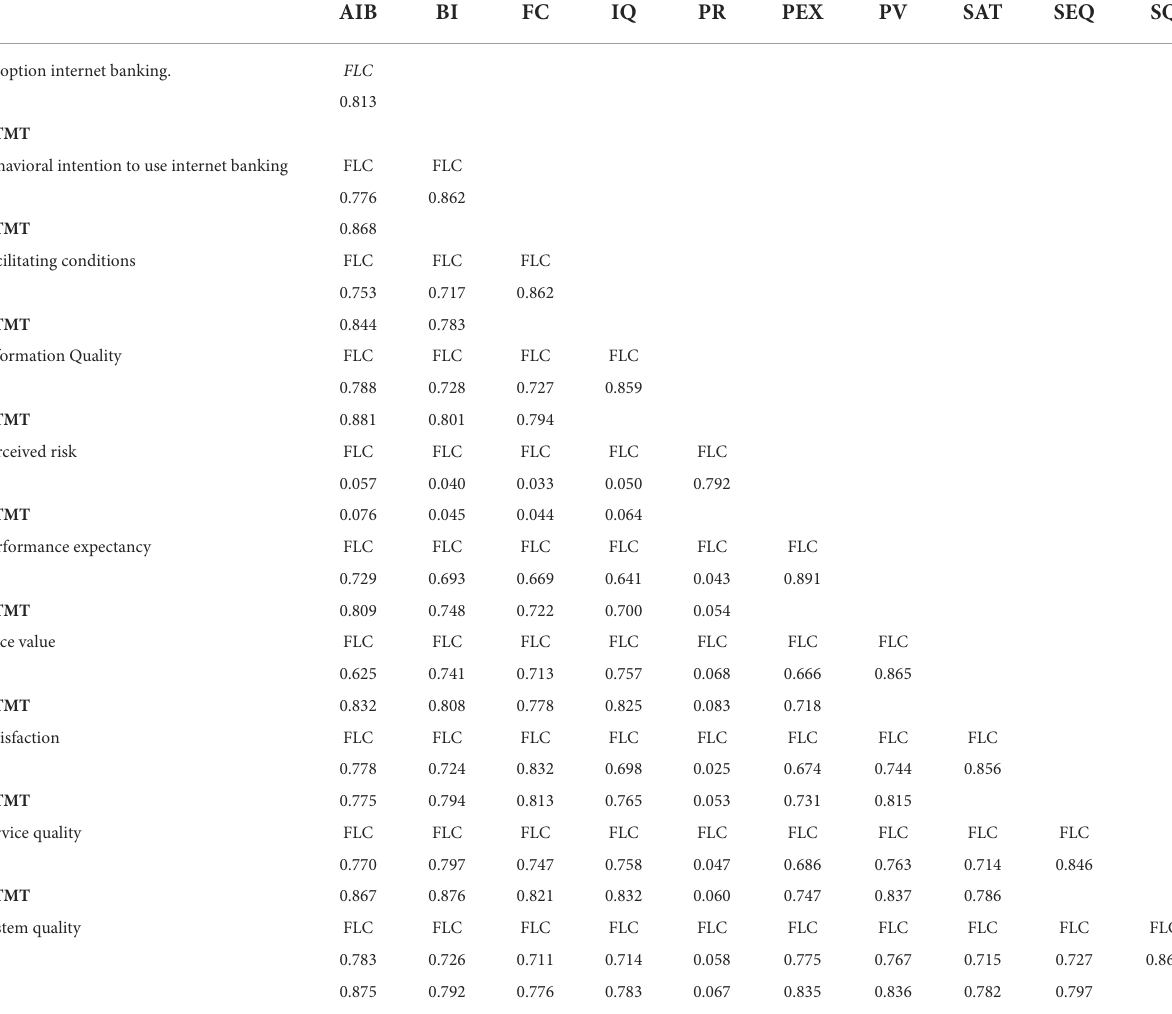
TABLE 3 Fornell-Larcker criterion (FLC) and (HTMT) for discriminant validity (HTMT <